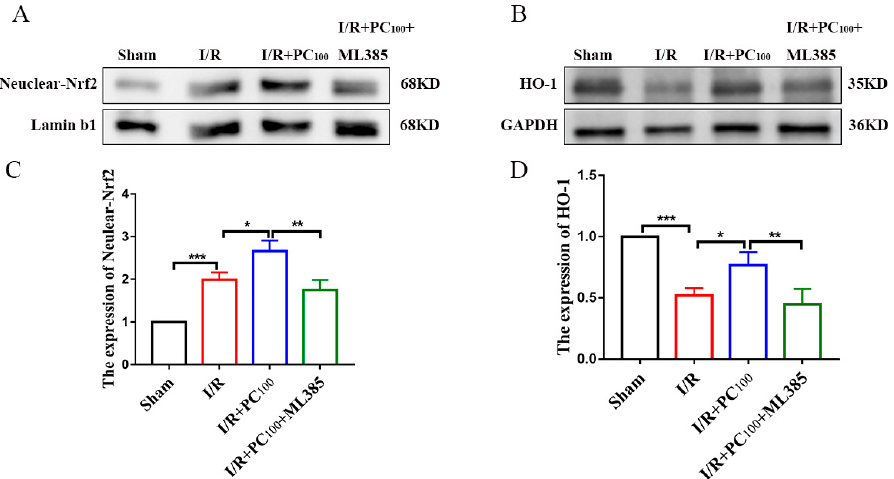
Figure 7. Procyanidins activated the Nrf2/HO − 1 pathway. ( A – D ) Expression of Nuclear − Nrf2 and HO − 1 in the brain tissue of mice with CIRI (n = 3). All values are expressed as mean ± SD. n.s: no signi fi cant di ff erence, * p < 0.05, ** p < 0.01, *** p < 0.001.